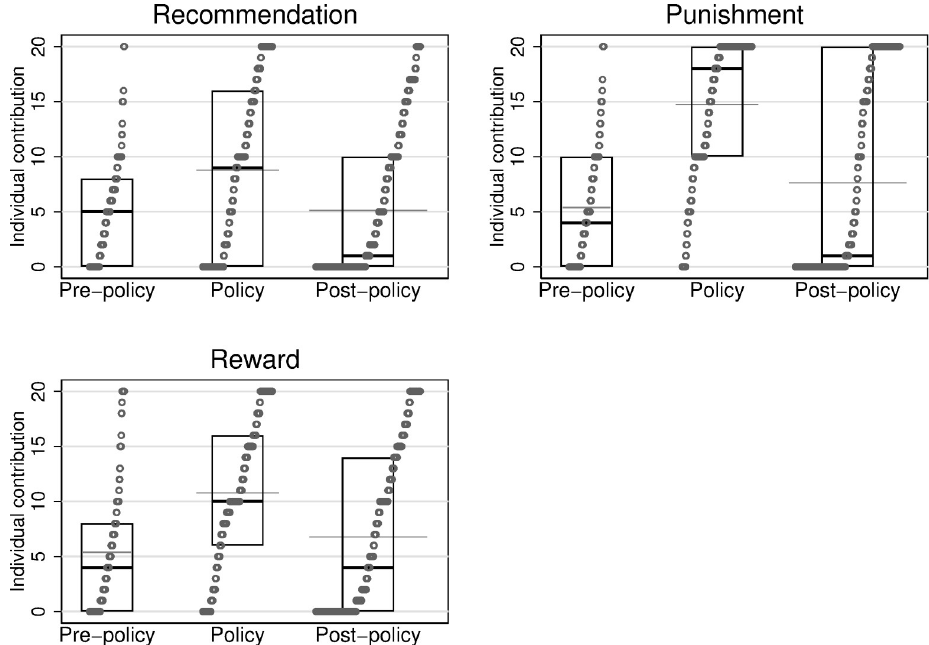
Fig 2. Quantile box plot for average individual